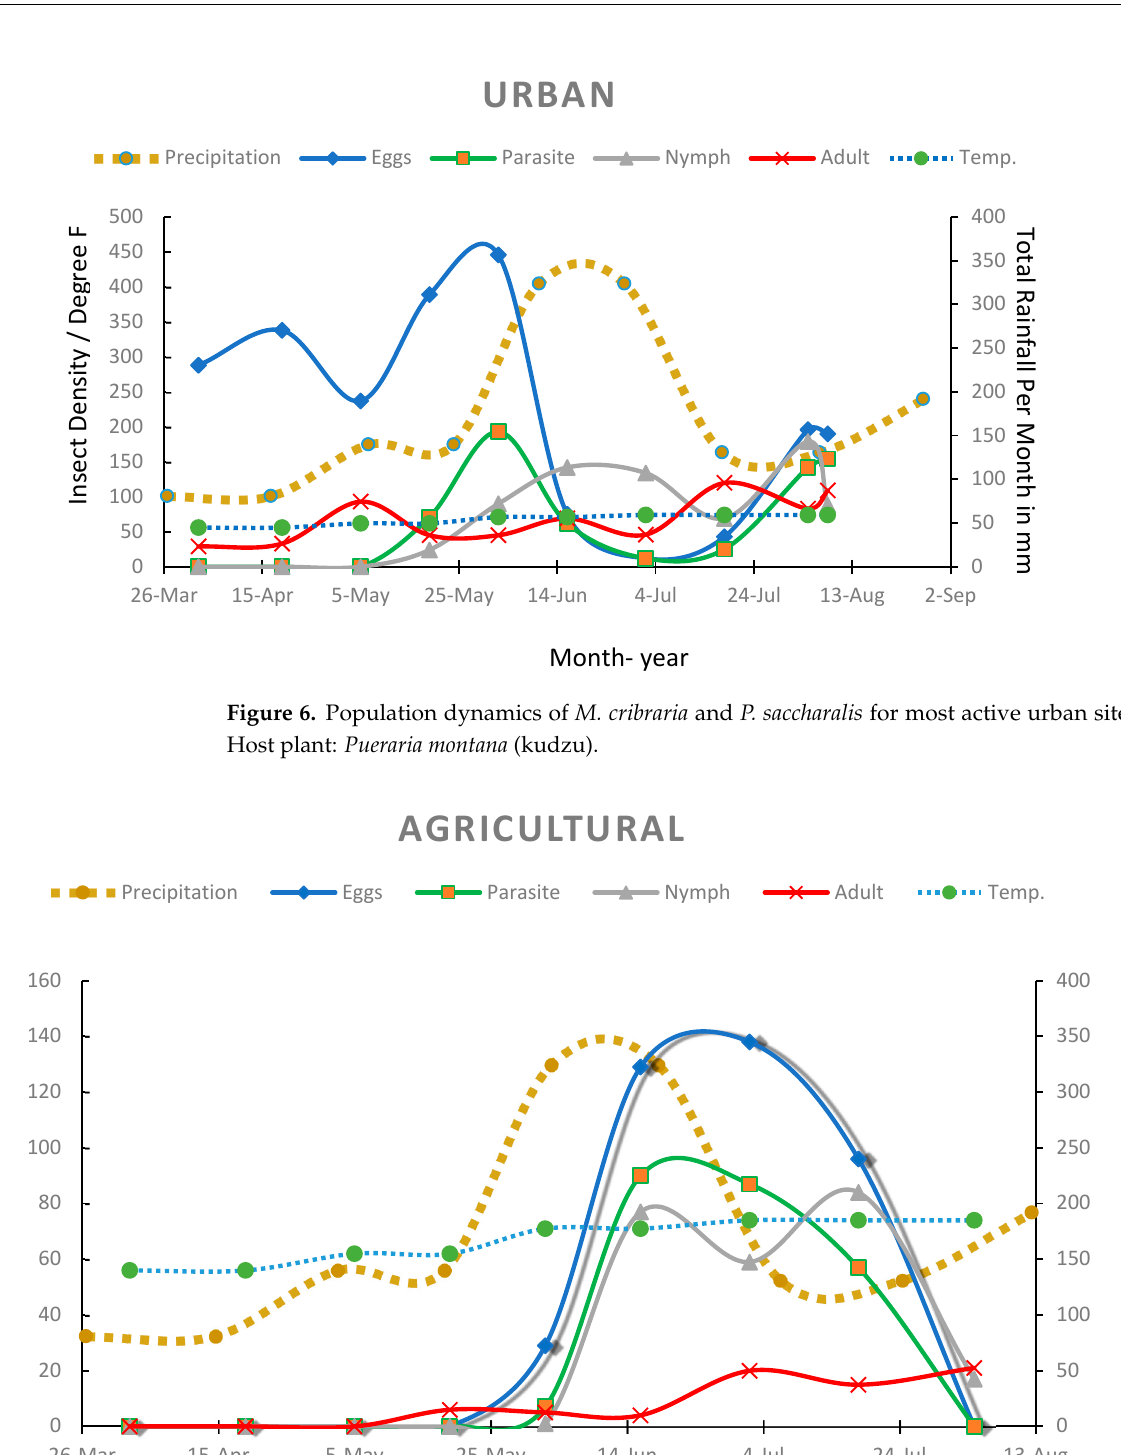
Figure 5. Population dynamics of M. cribraria and P. saccharalis for most active forested site in 2017. Host plants: Pueraria montana (kudzu).